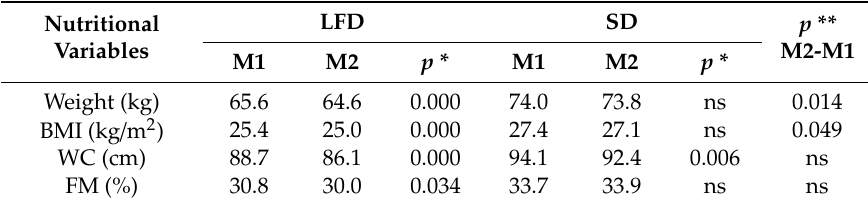
Table 4. Anthropometric measures and body